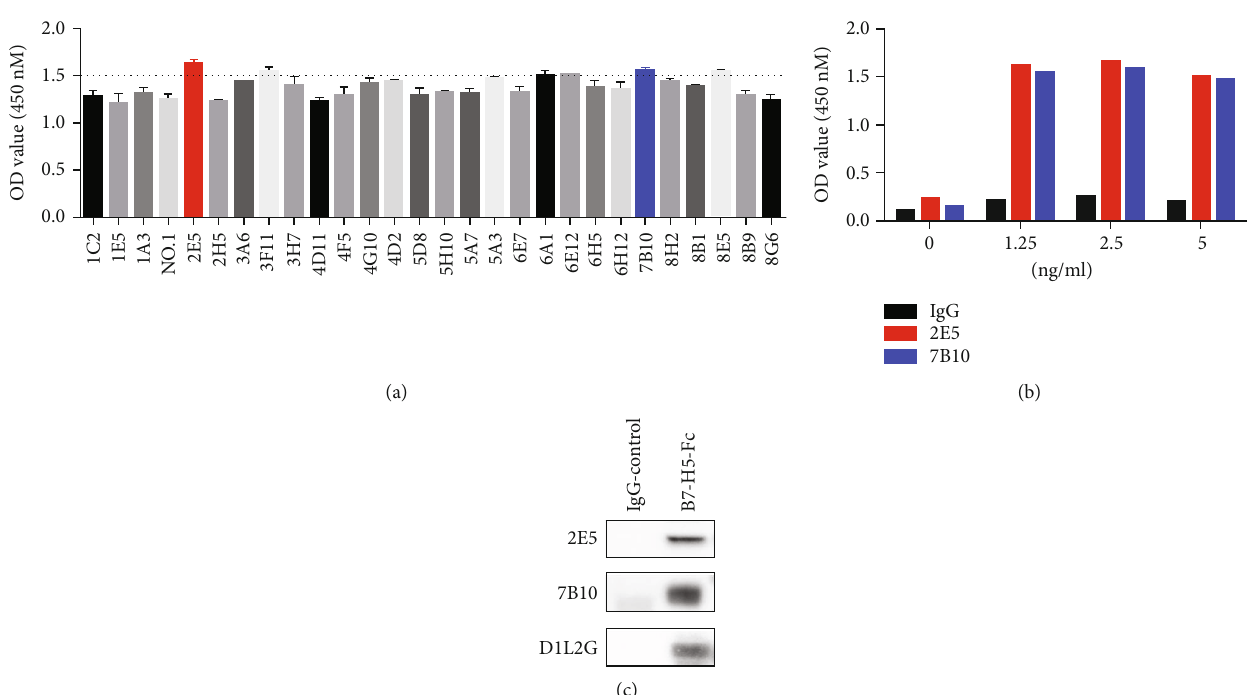
Figure 1: Characterization of B7-H5 monoclonal antibodies (mAbs). (a, b) Indirect ELISA was used to determine the binding ability of antibodies to immobilize B7-H4 Fc. (c) Western blot showed the antibodies recognized B7-H5 protein.